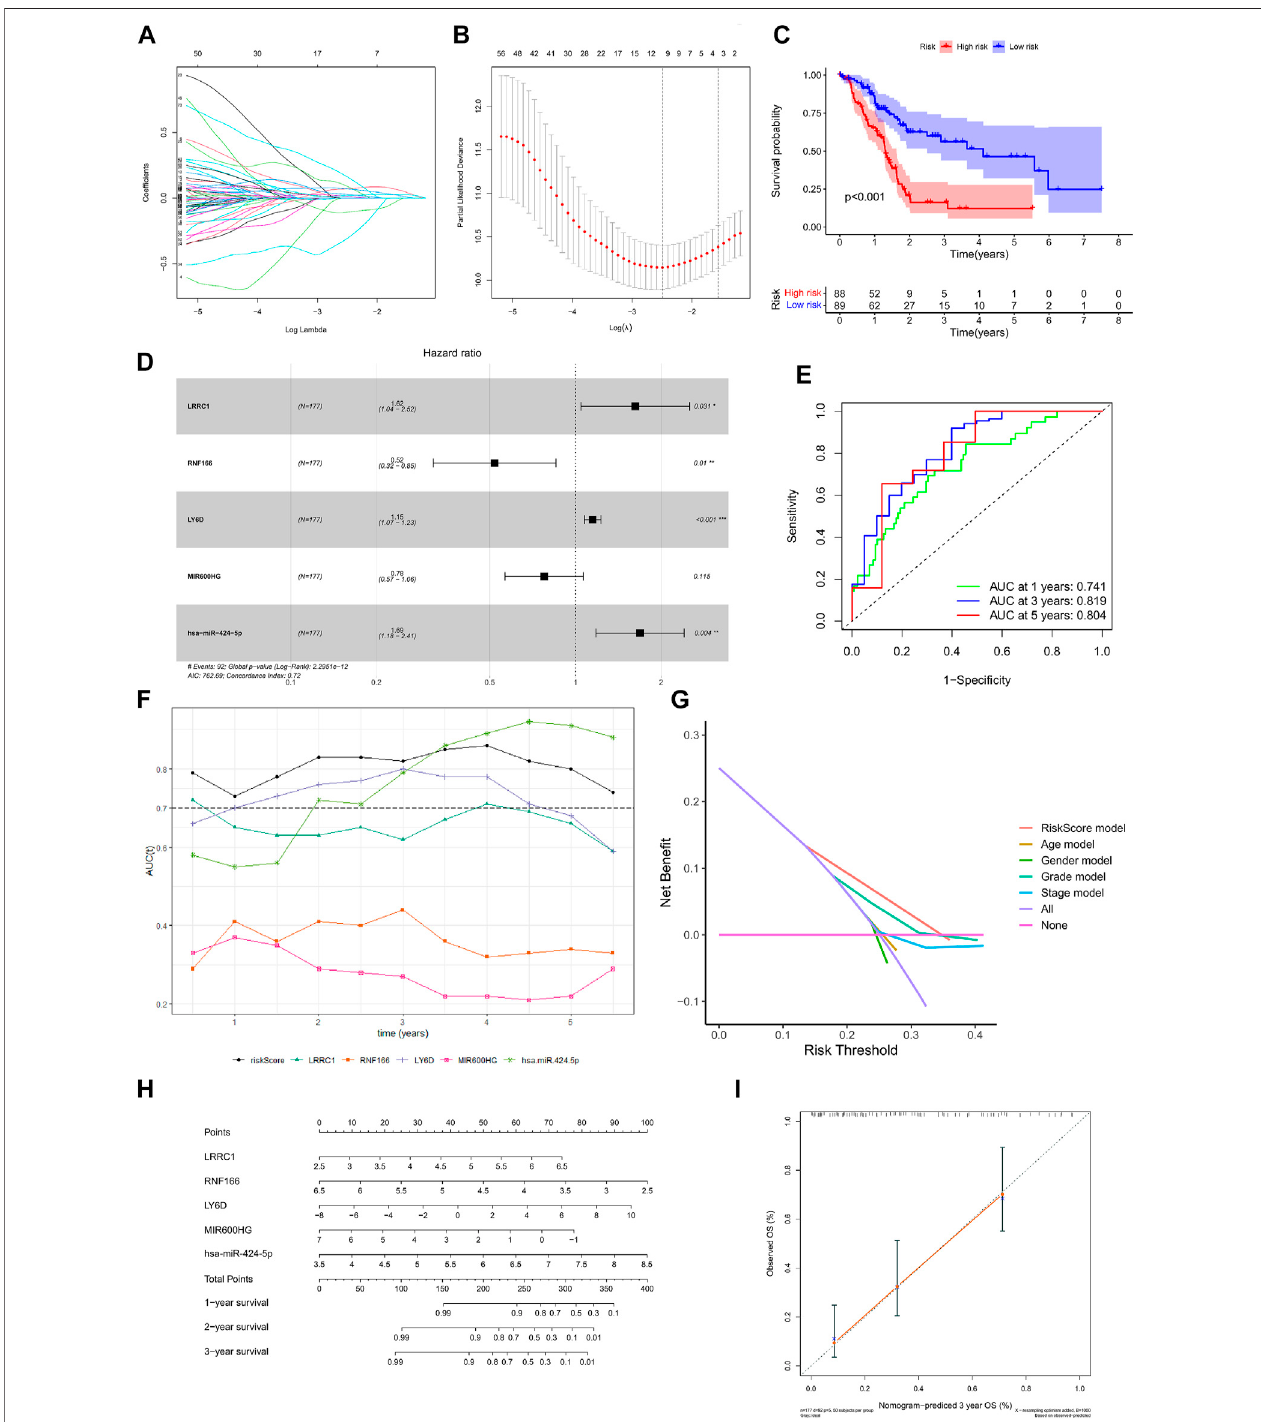
FIGURE 5 | Construction of the nomogram for predicting the survival probability of PAAD based on the identi fi ed hub genes in ceRNA networks. Results of Lasso regression (A, B) ; Kaplan – Meier survival curve in high- and low-risk groups based on the multivariate Cox regression analysis (C) ; forest plot of the multivariate Cox regression analysis (D) ; ROC curves of the multivariate Cox model (E) ; area under the multi-indicator ROC curve (F) and decision-making curve (G) ; nomogram (H) and its calibration curve (I) .